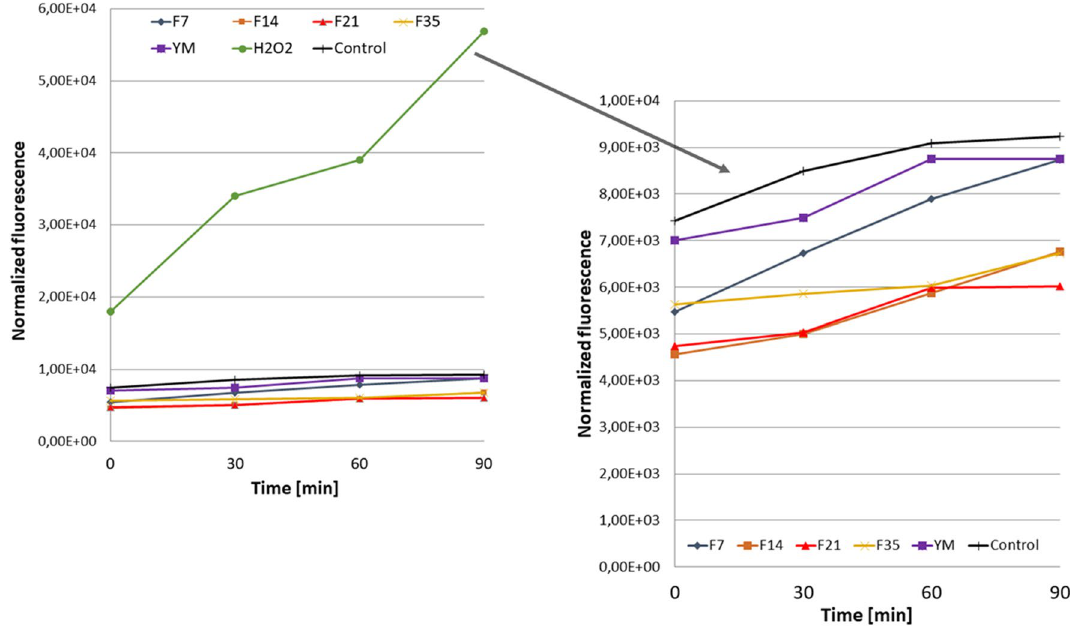
Figure 4. Effect of Yerba Mate and Kombucha ferments (at a concentration of 250 µg/mL) on the DCF fluorescence in fibroblasts. Data are expressed as the mean of 3 independent experiments each consisting of three replicates per treatment group.